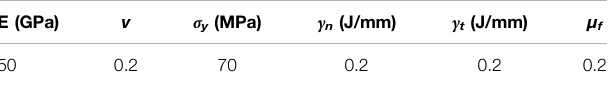
TABLE 1 | Material parameters of the XFEM